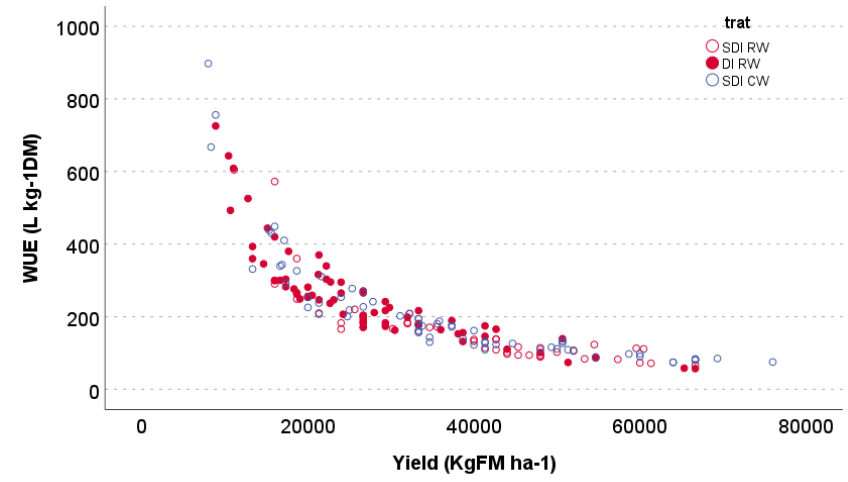
Figure 3. Curvilinear relation between WUE (L·kg −1 dry matter) and yield (expressed as kg FM·ha −1 ) for all treatments.